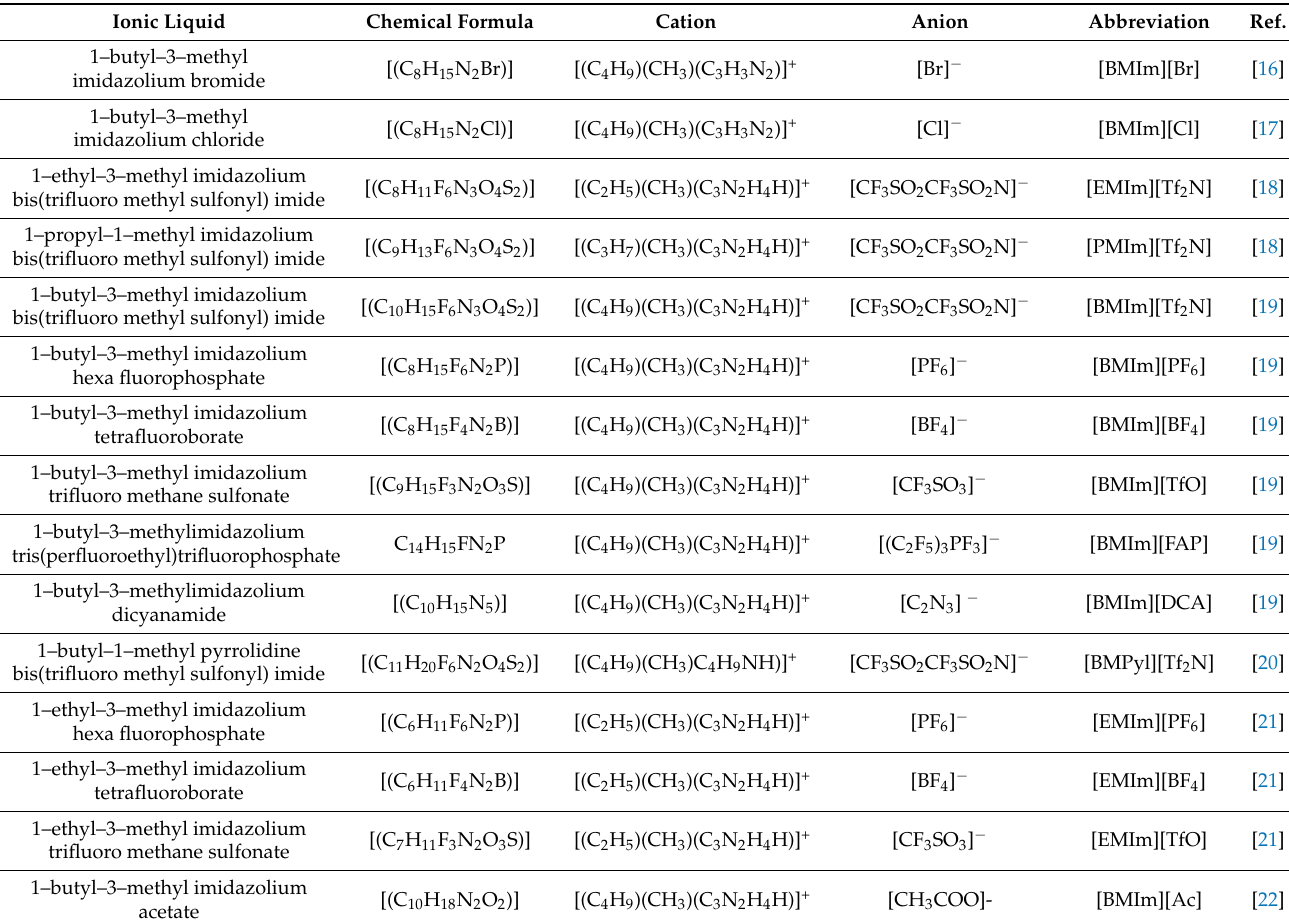
Table 1. List of ionic liquids (ILs) discussed in this